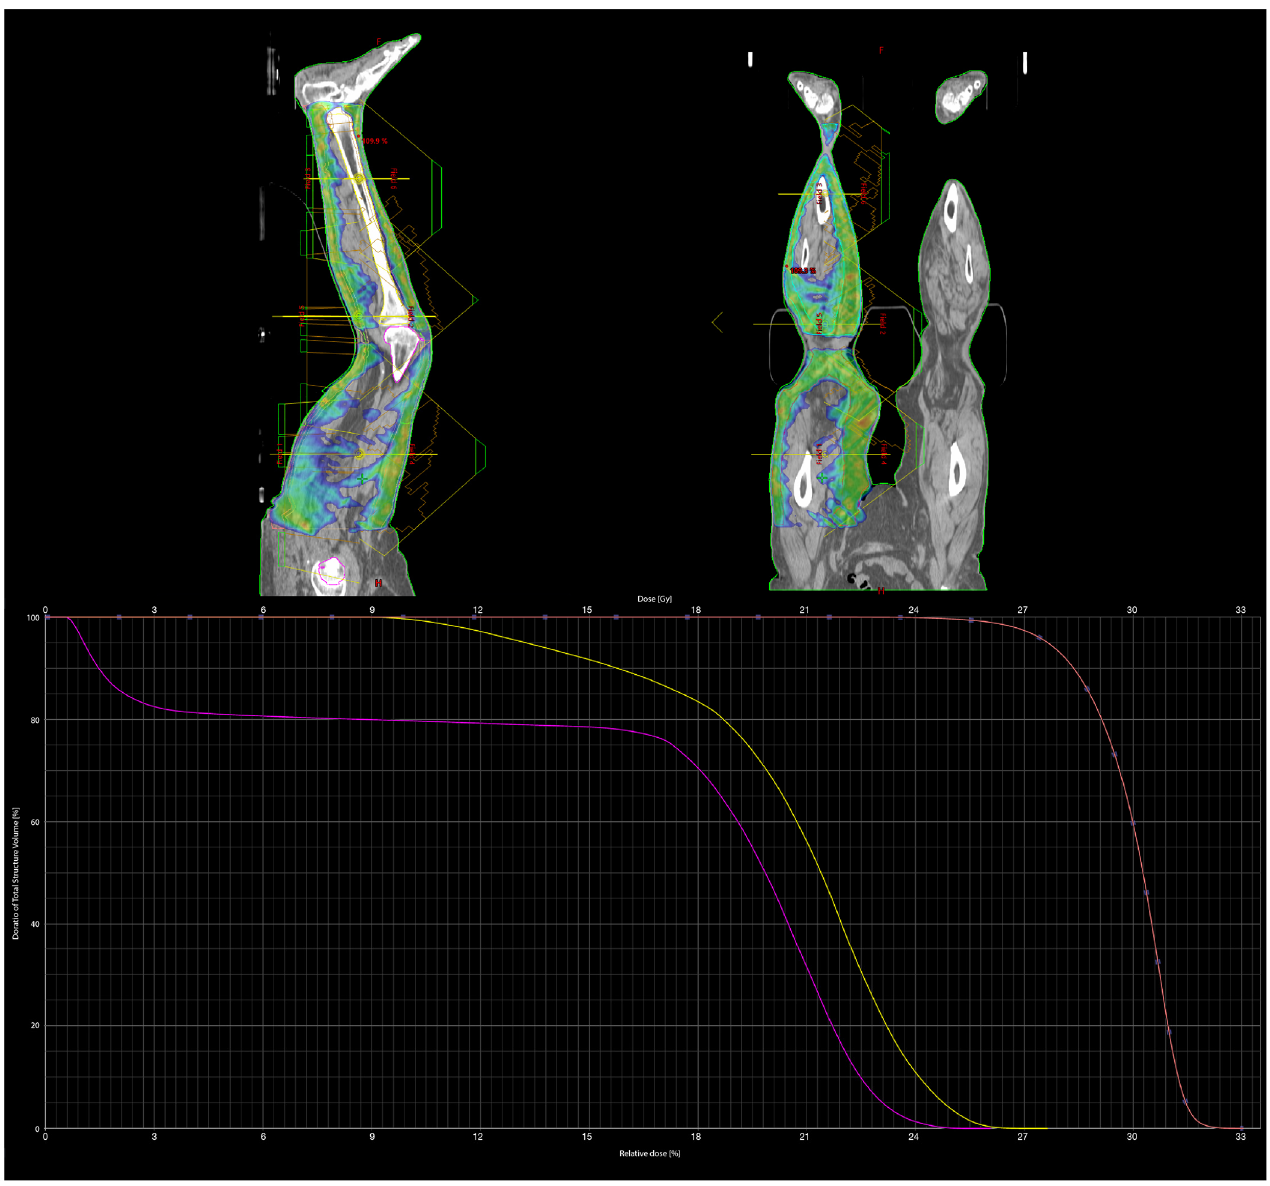
Figure 4. 90% isodose lines in sagittal and coronal planes with fields and dose–volume histogram (DVH) for PTV (light red), femur (fuchsia) and tibia (yellow).